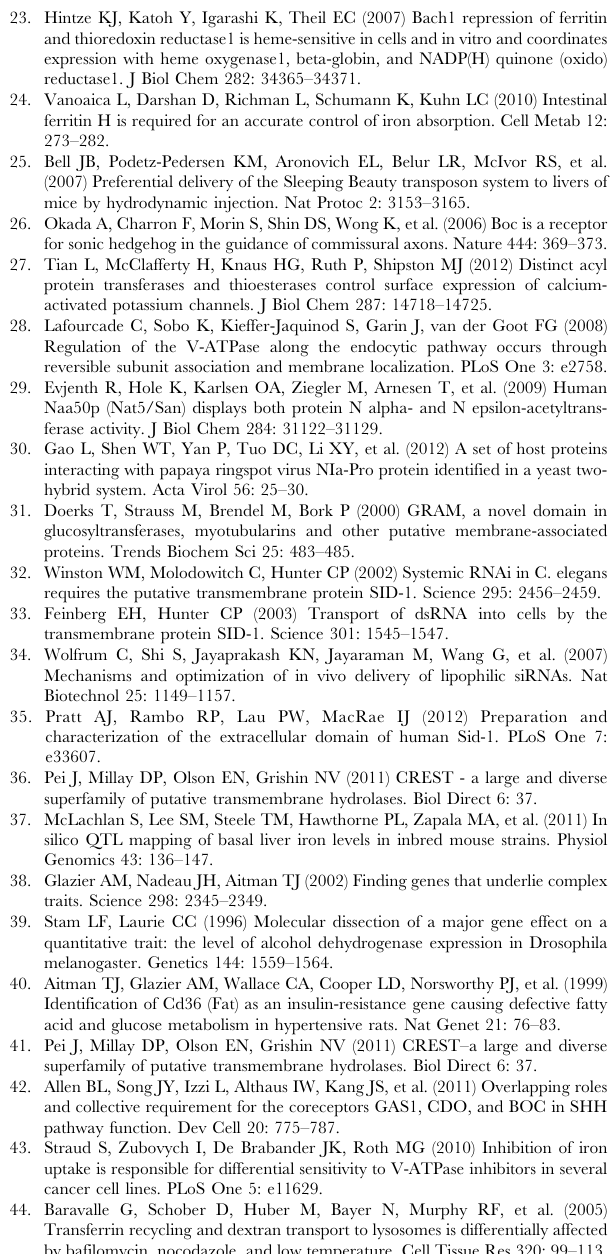
Table S3 Interval candidate gene accession